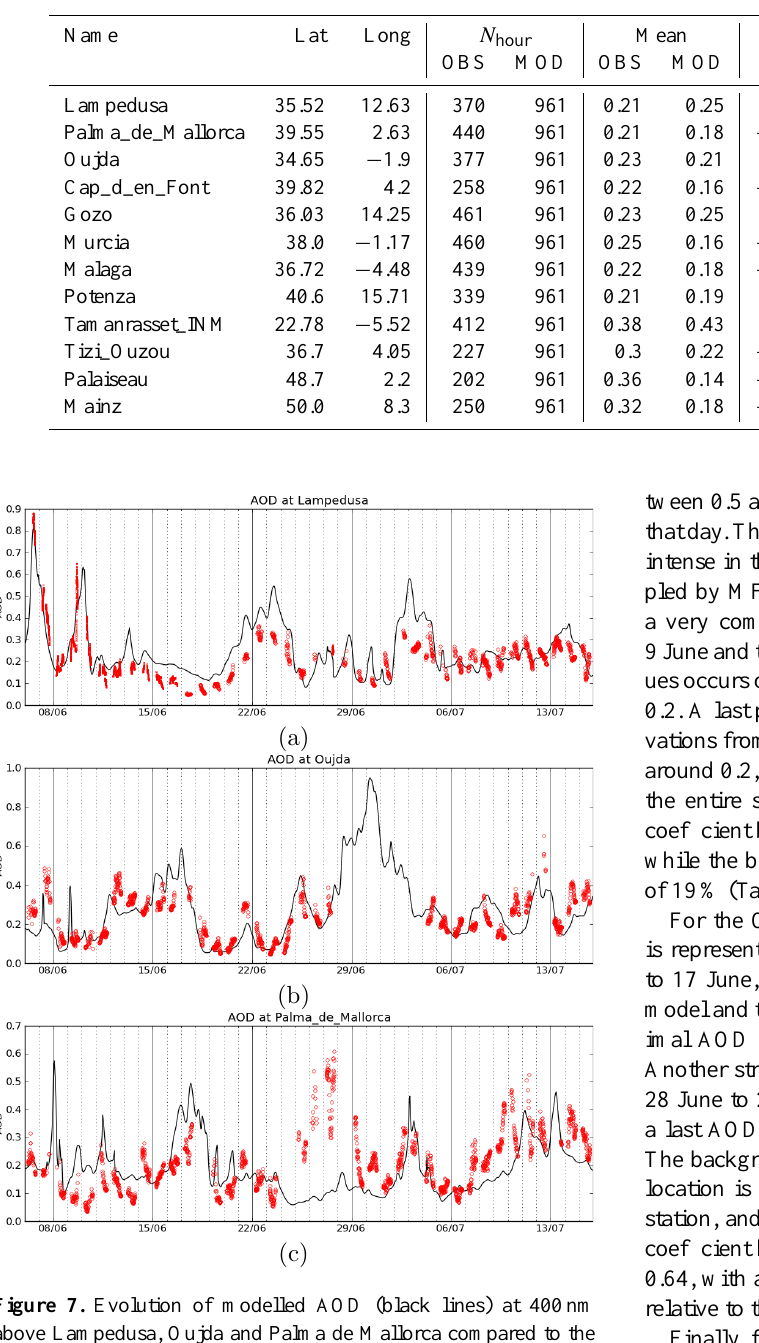
Table 3. Statistical scores for comparison of modelled AOD values at 400nm (from the REF simulation) and observed ones, from AERONET network data (completed when necessary by the MFRSR data in the case of Lampedusa). For each station, the following data are given: name and geographical coordinates of the station, number of hourly values ( N hour ), mean value and standard deviation ( σ ) of observed and modelled data, correlation coefficient R and two-sided p value for a zero hypothesis with null slope.